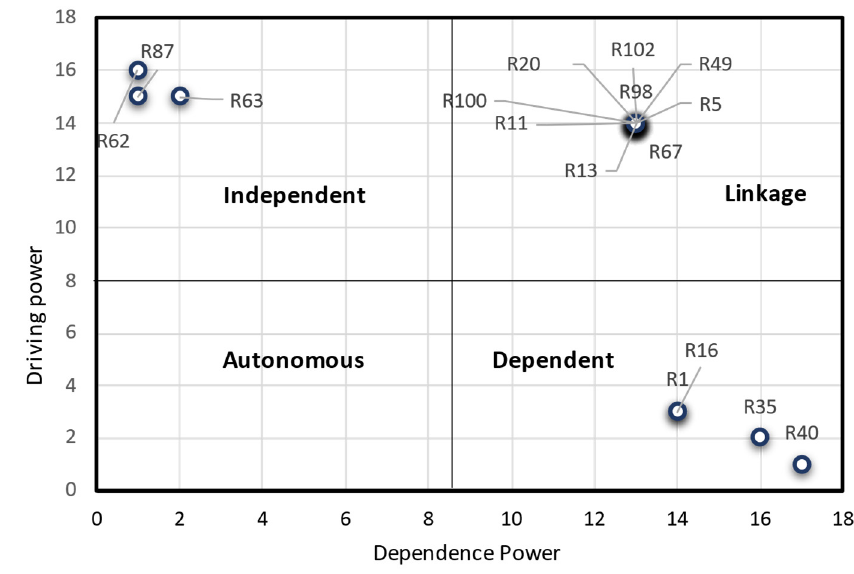
Figure 6. MICMAC